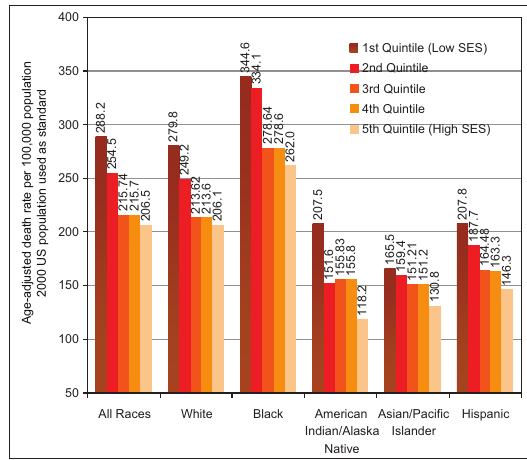
Figure 4 : Cardiovascular Disease (CVD) Mortality by Race/ Ethnicity and Socioeconomic Deprivation Level, United